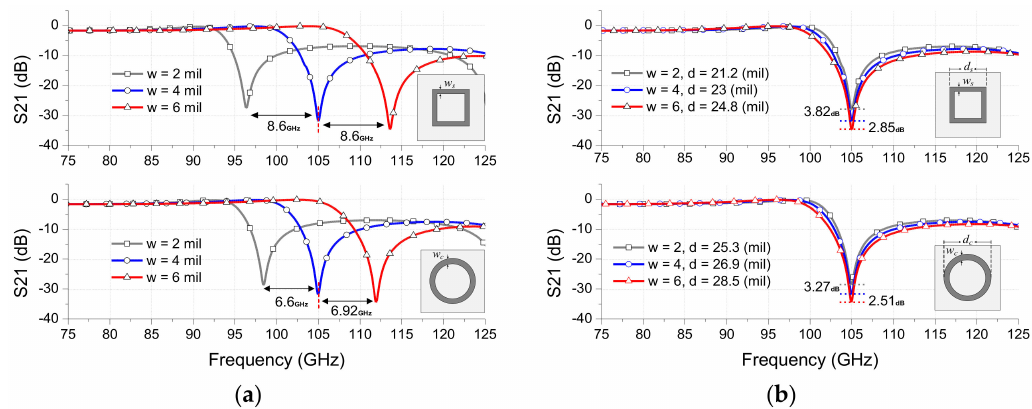
Figure 5. Effects of the loop width w on the loop-type FSSs: ( a ) Fixing d , p and g parameters, ( b ) Adjusting d with fixed p and g .